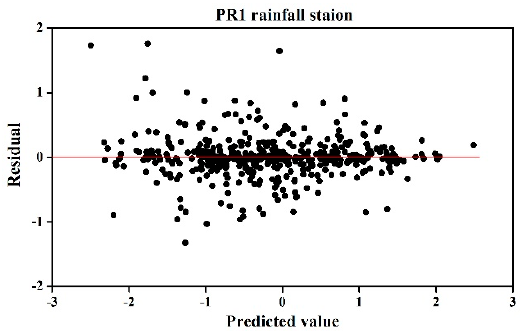
Figure 5. The scatterplot of the residuals against predicted values at the PR1 station.